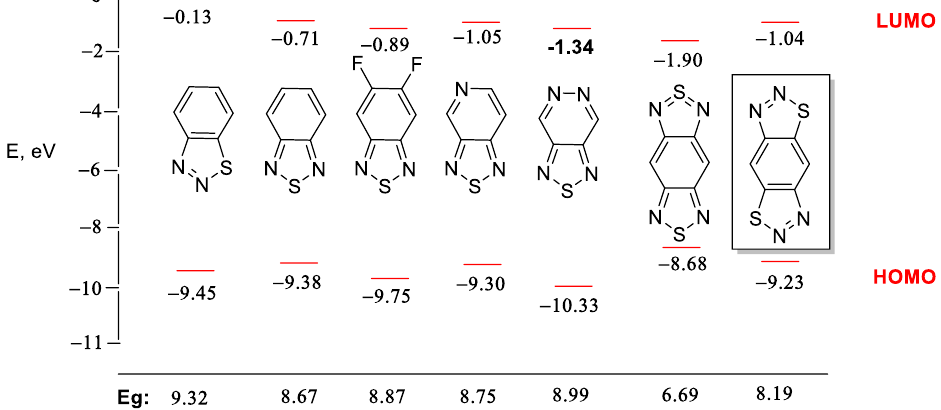
Figure 1. HOMO–LUMO energy levels and energy gap values for electron-deficient heterocycles for 2,1,3-benzothiadiazole, as well as its derivatives and isomers.